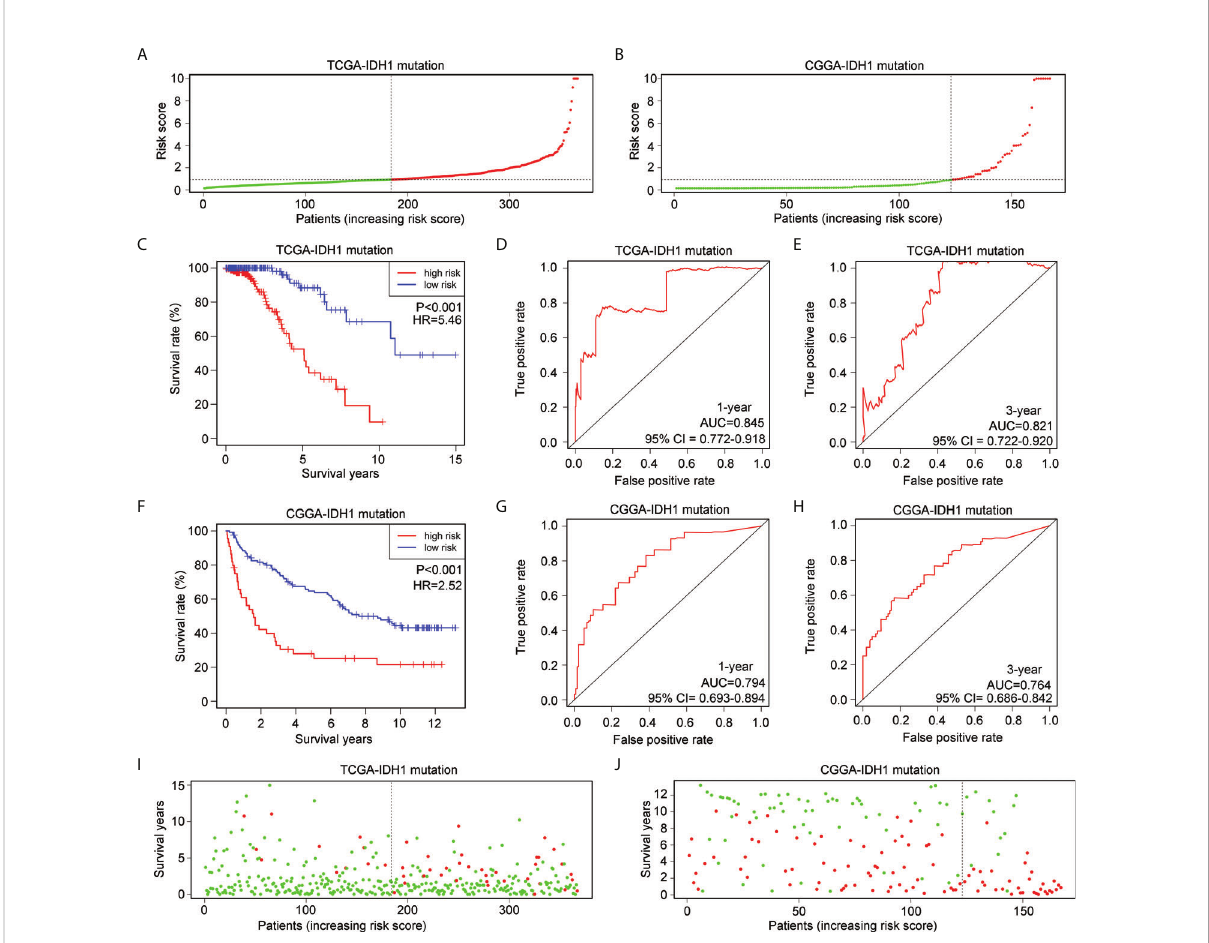
FIGURE 5 Veri fi cation of the applicability of the risk model in IDH1mt-glioma patients in TCGA and CGGA databases. (A, B) IDH1mt-glioma patients in TCGA and CGGA databases were divided into high- and low-risk score groups according to the median of risk scores. (C) The survival difference between high- and low-risk score group IDH1mt-glioma patients in TCGA. (D, E) The diagnostic value of risk model for one- and three-year survival in IDH1mt-glioma patients in TCGA. (F) The survival difference between high- and low-risk score group IDH1mt-glioma patients in CGGA. (G, H) The diagnostic value of risk model for one- and three-year survival in IDH1-mt glioma patients in CGGA. (I, J) Death cases in high- and low-risk score group IDH1mt-glioma patients in TCGA and CGGA (Green dots mean alive cases, red dots mean death